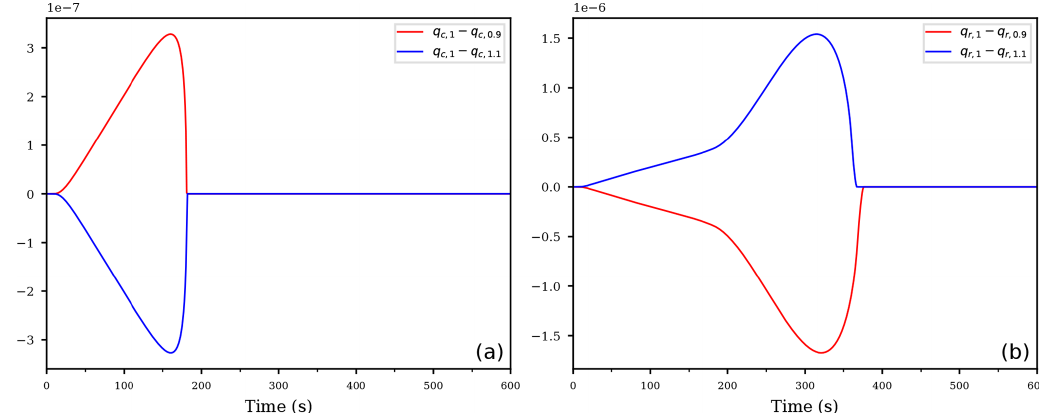
Figure 8. Difference between the reference run with unperturbed coefficient e 2 , denoted as q x, 1 for x ∈ { c, r } and using the perturbed second evaporation coefficient s · e 2 with s ∈ { 0 . 9 , 1 . 1 } , denoted as q x, 0 . 9 or q x, 1 . 1 , for the cloud droplet mixing ratio (a) and the rain mixing ratio (b) ,